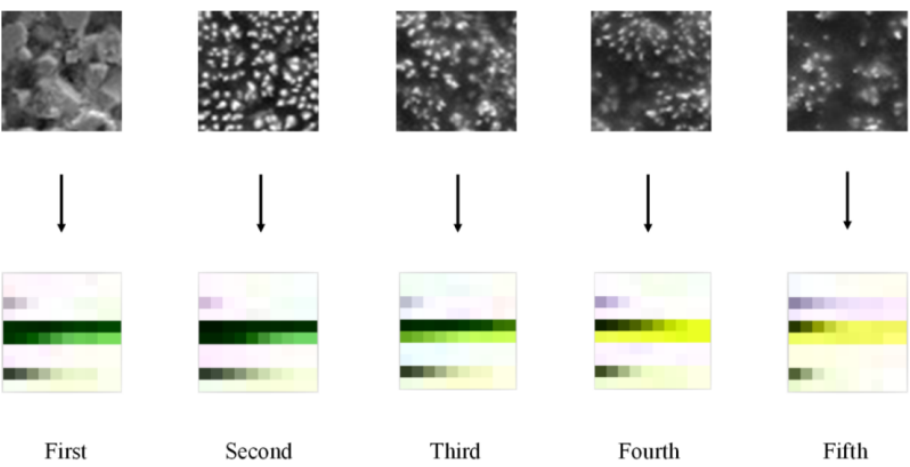
Figure 7. Fractal feature images were reconstructed from oxidized surface clipping images of ZrB 2 –SiC under different numbers of thermal shock cycles.